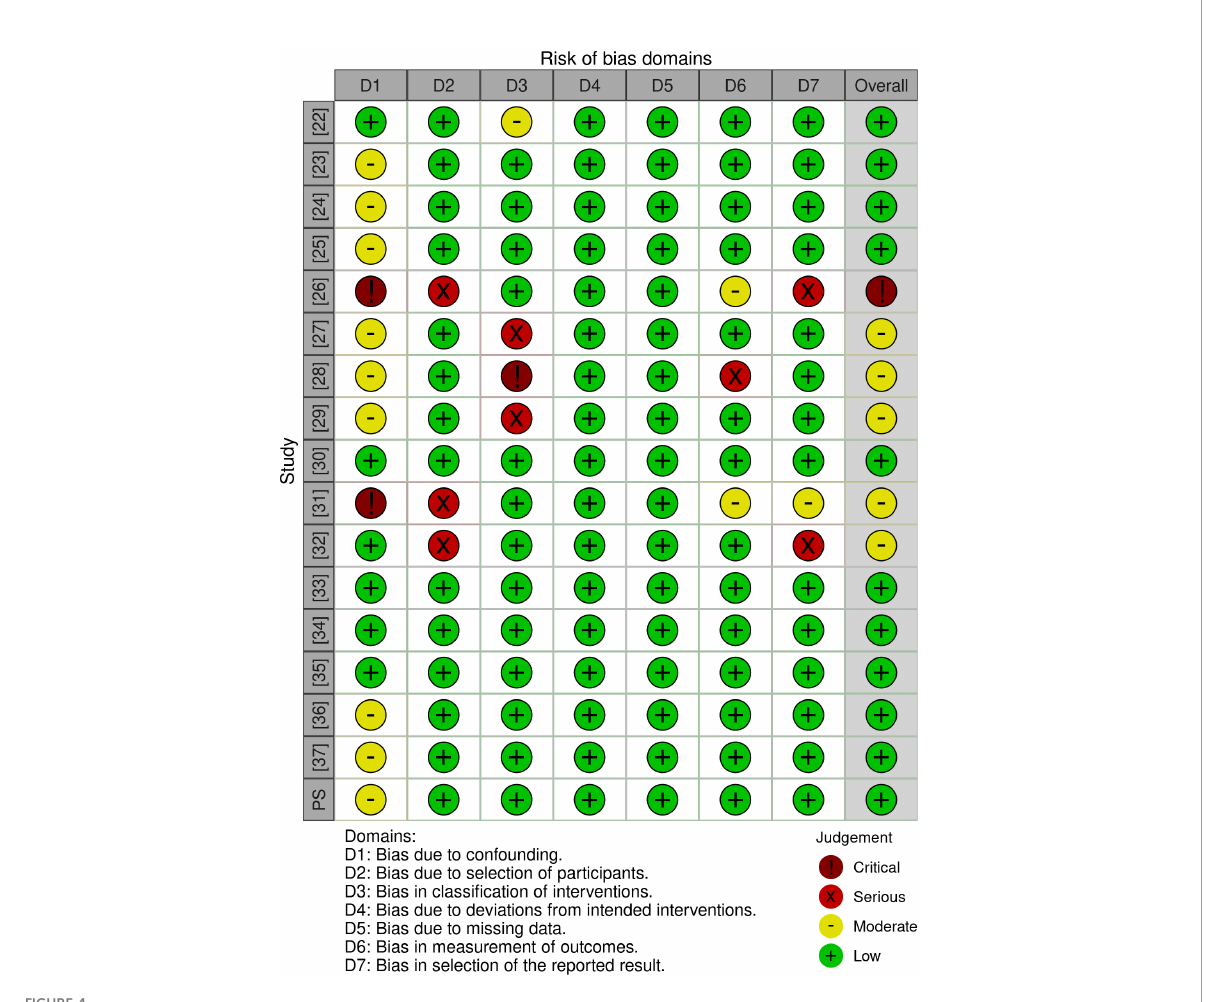
FIGURE 4 ROBINS-I for Individual studies. Caption: Within parentheses, the number represents the study reference. PS: Present